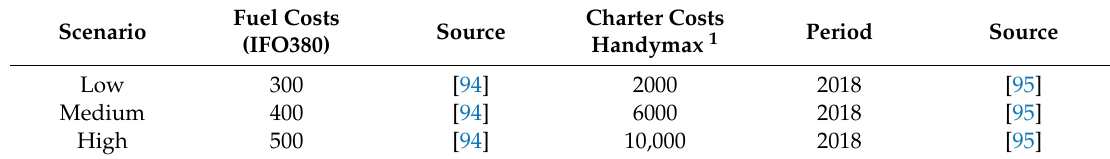
Table A5. Shipping fuel and charter costs variation, in € / t for fuel costs and € / day for charter costs.